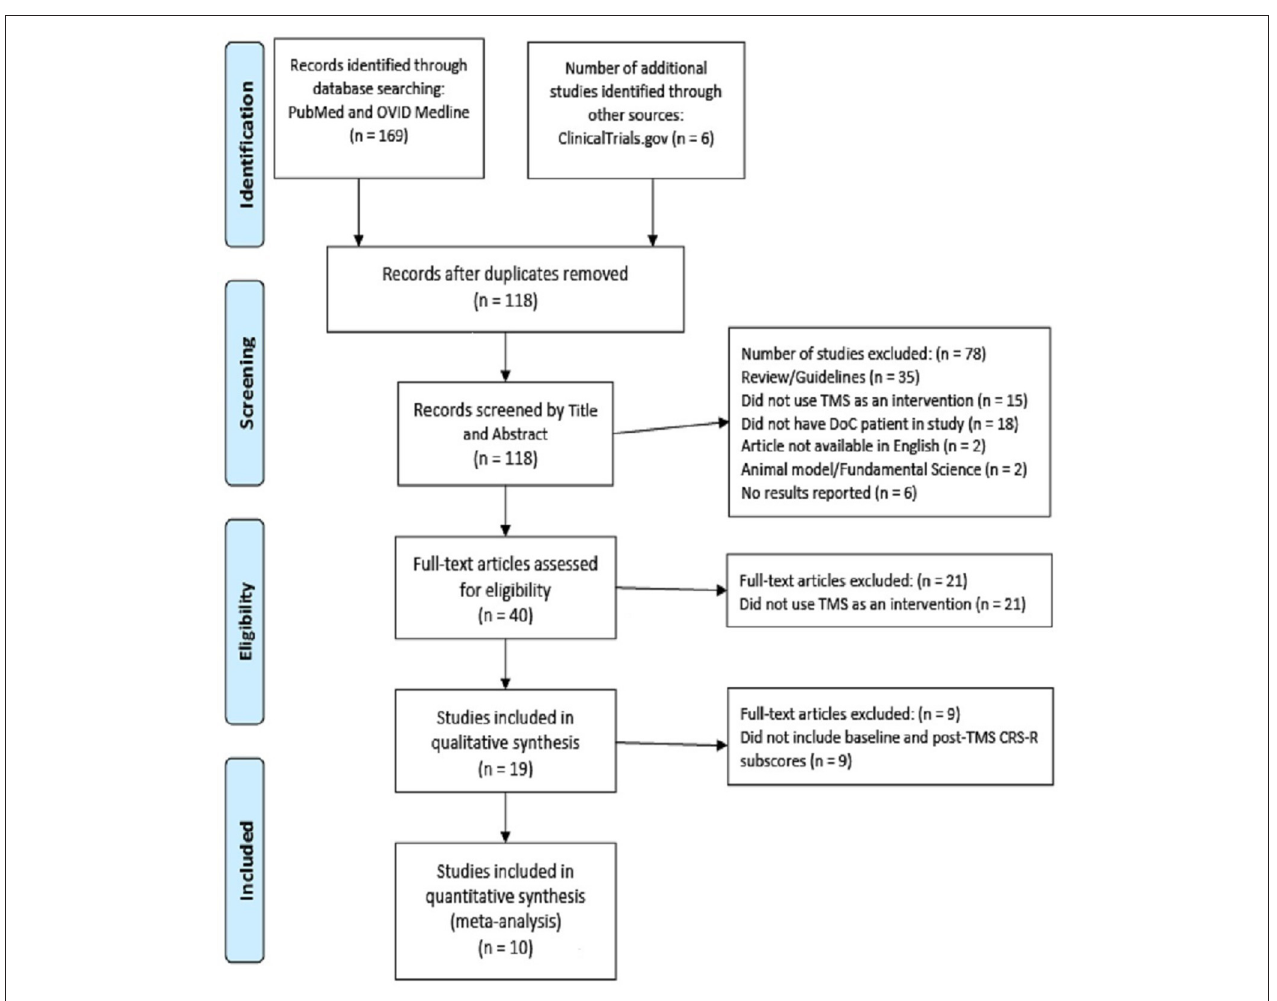
FIGURE 1 | PRISMA diagram. CRS-R, Coma Recovery Scale-Revised; DoC, Disorder of Consciousness; PRISMA, Preferred Reporting Items for Systematic Reviews and Meta-Analyses; TMS, Transcranial magnetic stimulation.